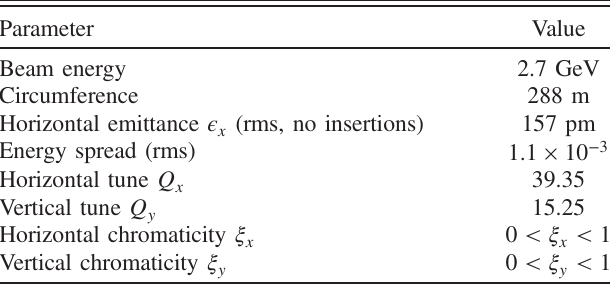
TABLE I. Basic parameters and design constraints of the considered SLS 2.0